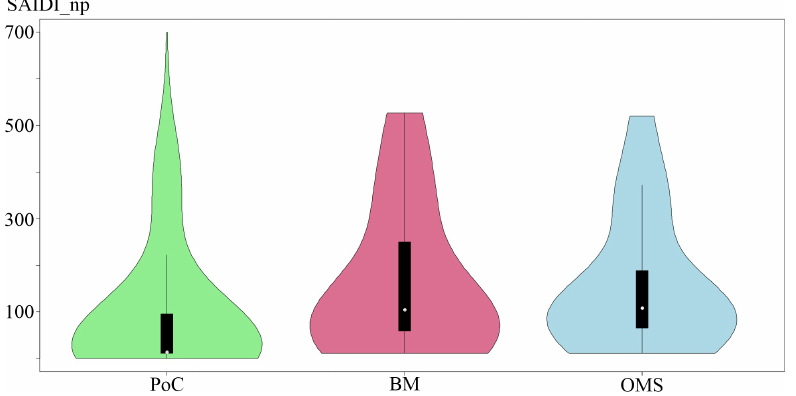
Figure 4. Vioplots of SAIDI_np for unscheduled events in the MV/LV transformer stations obtained on the basis of data from PoC, BM and